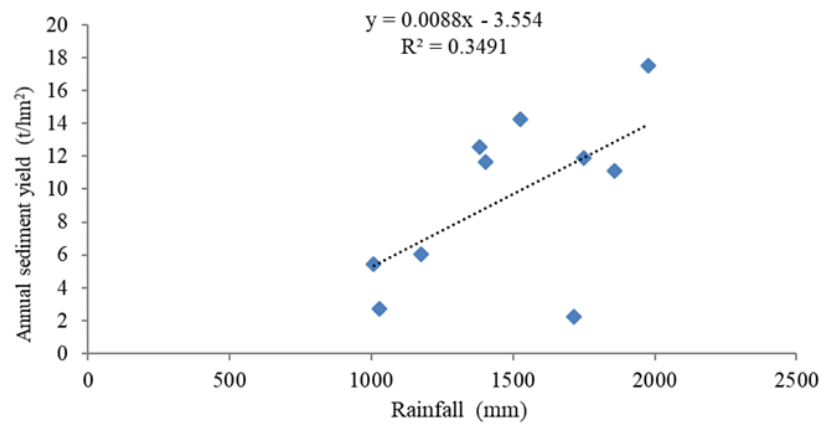
Figure 12. Relationship between rainfall and annual sediment yield.